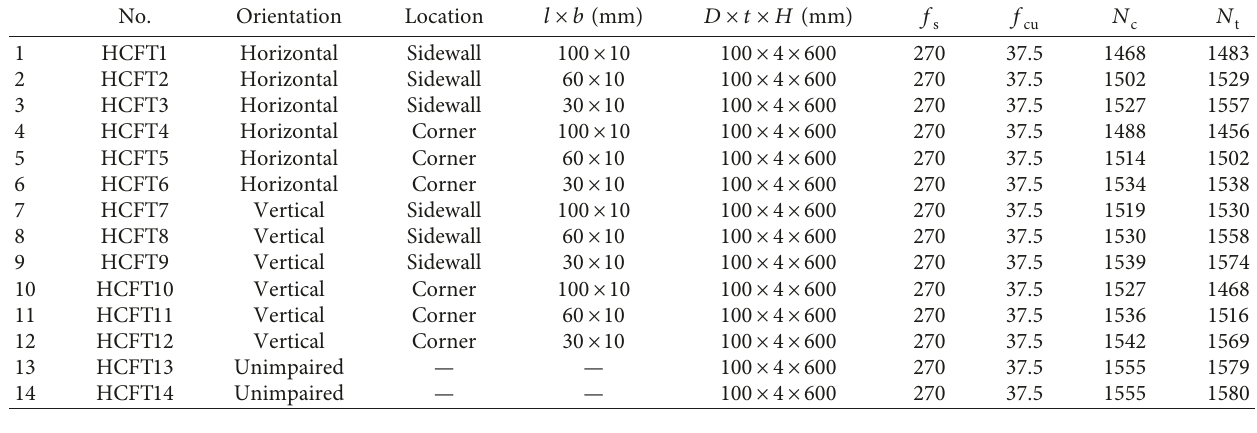
Table 1: Geometric properties and characteristics of CFST columns.